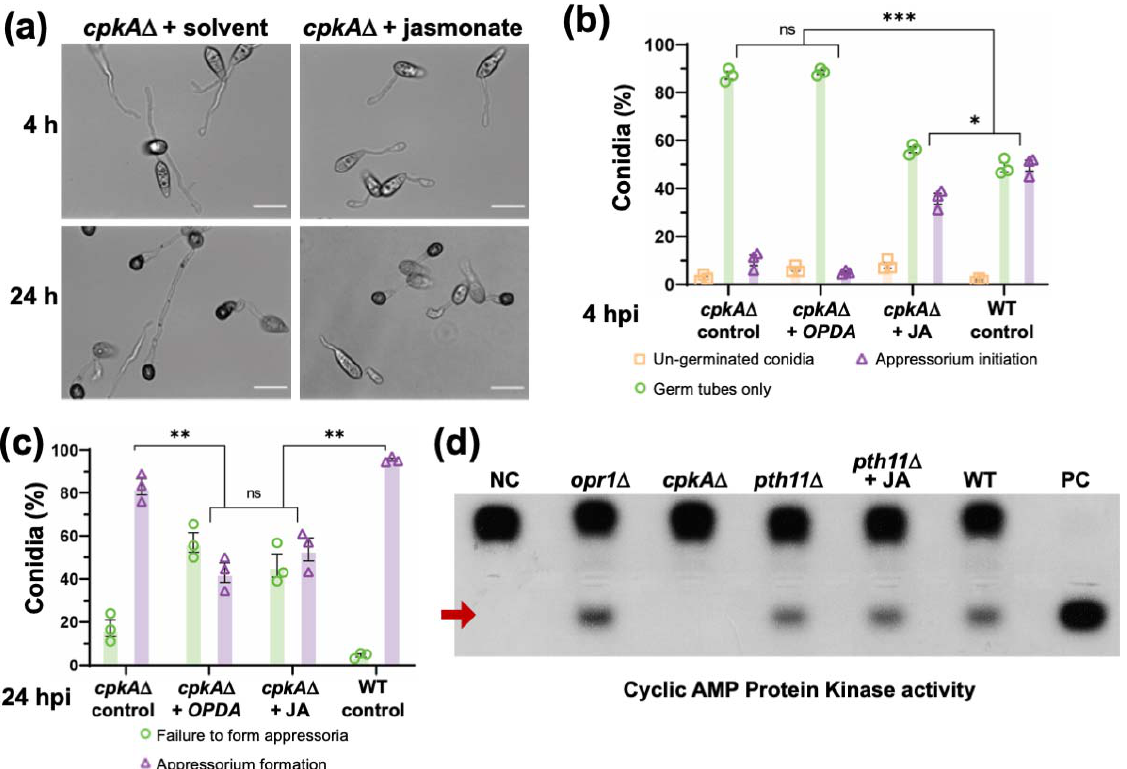
Figure 7. JA signaling functionally interconnects with the cAMP cascade at the CPKA node. ( a ) Exogenous JA, but not cis-OPDA, suppresses only the germ tube growth defect in the cpkA ∆ mutant. Conidia from the cpkA ∆ strain were treated with JA or cis-OPDA and germ tube development and appressorium initiation and formation were analysed at 4 hpi and 24 hpi, respectively. Scale bar equals 10 micron. ( b , c ) JA or cis-OPDA fail to restore proper appressorium development in cpkA ∆ . Bar graphs representing quantitative data analysis for the experiment described in ( a ). Although the oxylipin-treated germ tubes were shorter in length, the percentage of appressorium formation in such JA or cis-OPDA treated cpkA ∆ conidia was significantly reduced. Data represent mean ± SE from three biological replicates each using 300 conidia as the sample size. * p < 0.05; ** p < 0.01; *** p < 0.001 (unpaired two-tailed t -test; ns Not significant; n = 3 experiments). ( d ) Loss of OPR1 or the supplementation with JA does not affect the intrinsic cAMP-Dependent Protein Kinase A (PKA) activity. Quantification of the intracellular cAMP PKA activity in total extracts from the indicated wild-type and mutant M. oryzae strains was performed using the non-radioactive CPKA assay system and the model substrate,